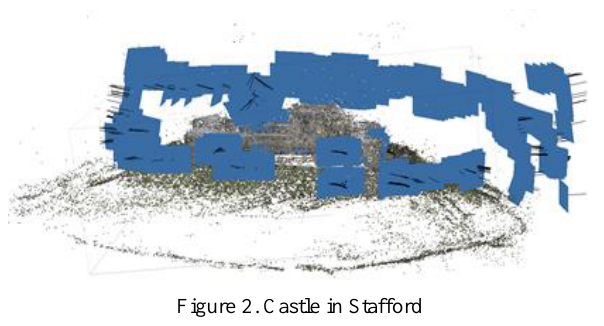
Figure 2. Castle in Stafford